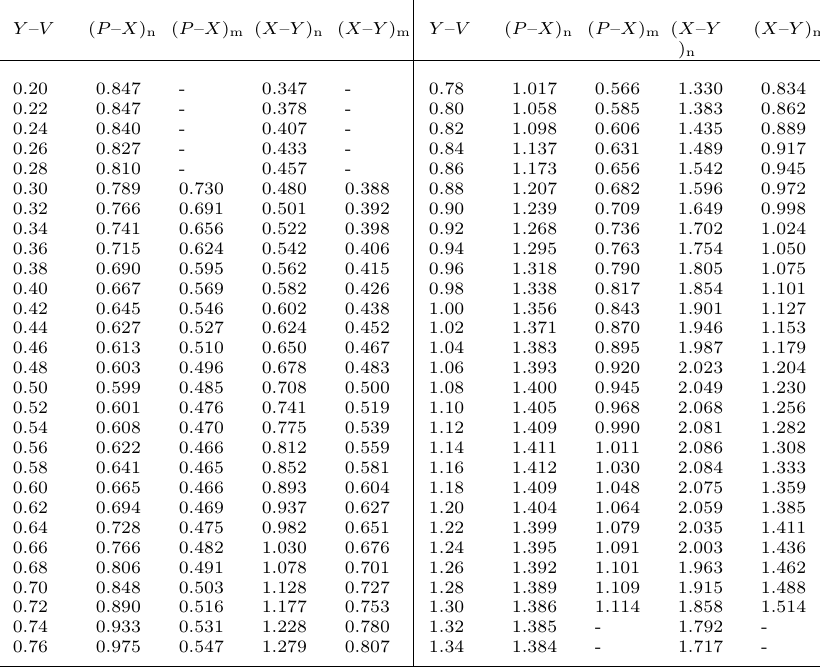
Table A4 . P – X vs. Y – V and X – Y vs. Y – V relations for luminosity class